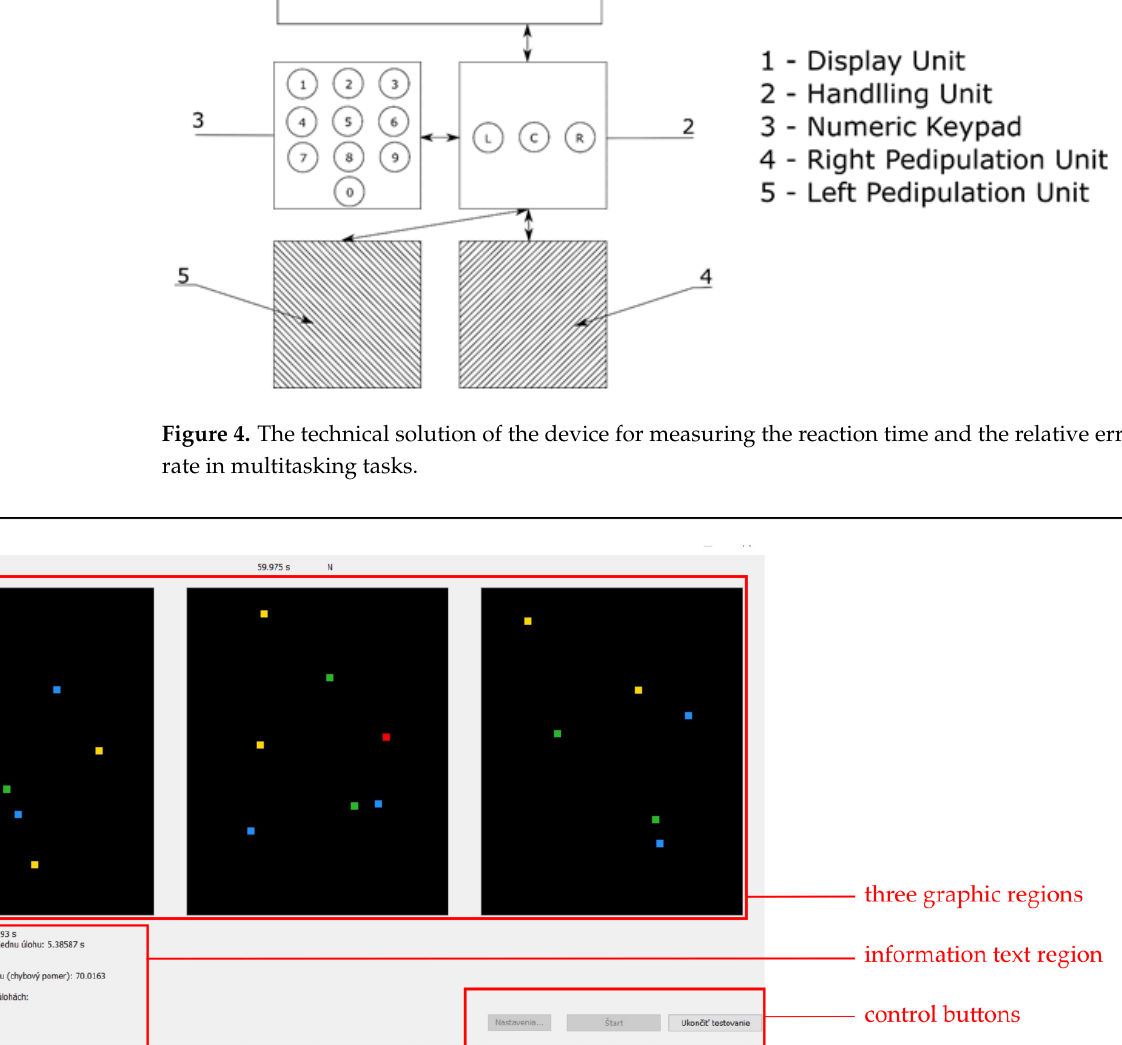
Figure 6. Settings window of the application for the testing device. There are 3 timers/counters used in the application: the first measures the time to complete the task, the second ensures moving to next task after 20 s, and the third is re- sponsible to play a chosen audio sound repetitively, each being 2 s, up to 9 times in one testing cycle. The three graphic regions serve to draw small squares while the red square, if it is drawn in a region, has a special meaning (see the Results section). The tasks generated for testing one subject are created randomly within the sets of 6 into a complete sequence of tasks in an array. Other sub-arrays used in the application include the arrays filled during this process with randomly generated colors (yellow, green, blue) and with identification of one from the three sectors of each graphic region randomly chosen for the approaches if needed. All the randomization processes are seeded with an unsigned int value of the